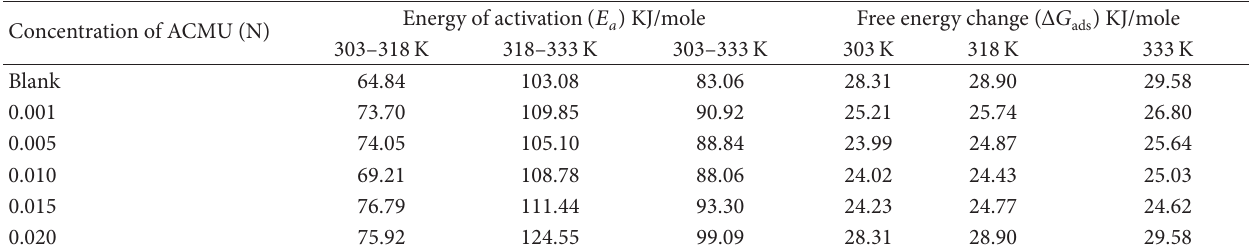
T 3: Calculated values of activation energy